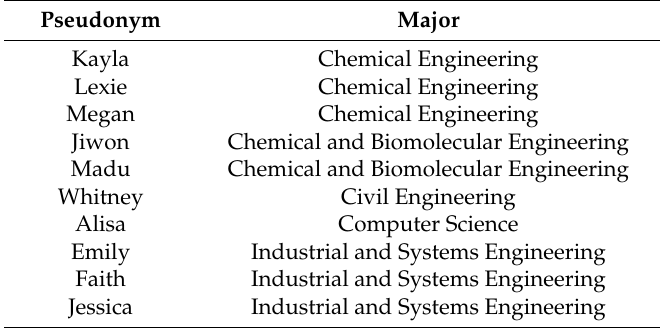
Table 1. Participants by